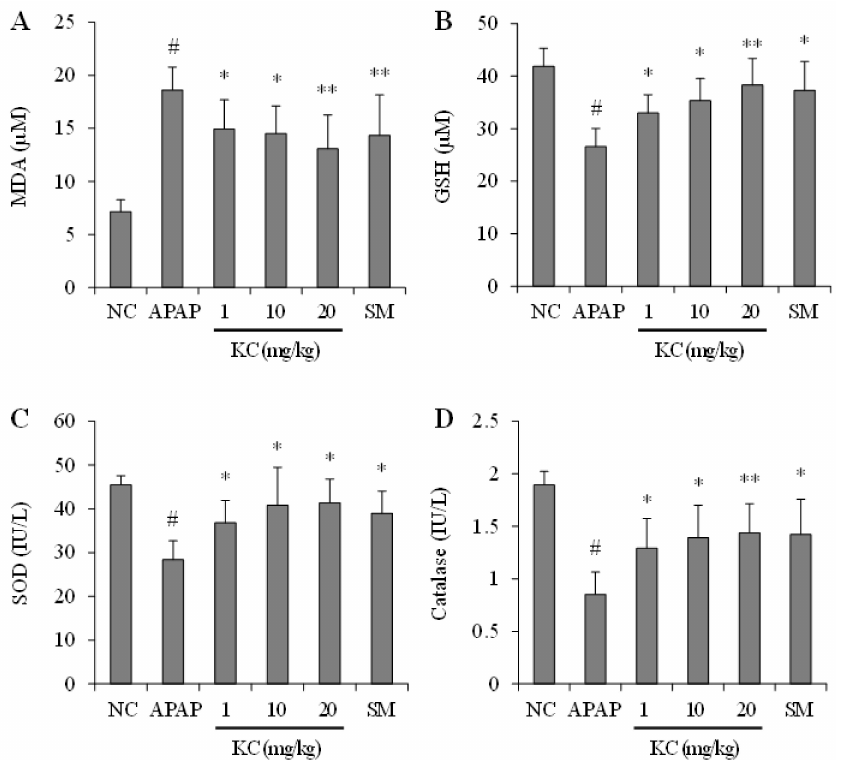
Figure 7. Effect of kushenol C on APAP-induced MDA production and suppression of antioxidant enzymes in mice. Thirty mice were partitioned into 6 groups (n = 5): group 1, normal control; group 2, APAP 500 mg/kg; group 3, APAP plus KC 1 mg/kg; group 4, APAP plus KC 10 mg/kg; group 5, APAP plus KC 20 mg/kg; group 6 (a positive control), APAP plus silymarin (SM) 50 mg/kg. ( A ) MDA levels, GSH ( B ), SOD ( C ), and catalase ( D ) were measured in the liver tissue. Error bars represent the mean ± SD, # p < 0.001 vs. NC group, * p < 0.05, ** p < 0.01 vs. APAP-only treated